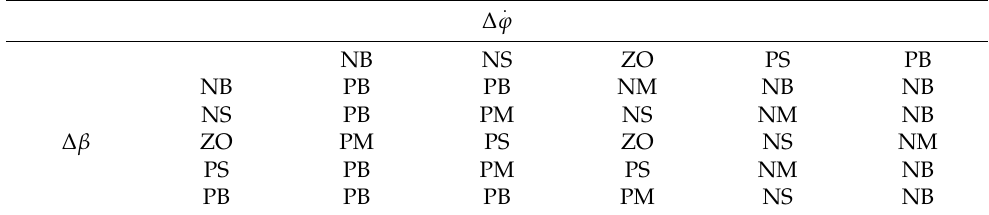
Table 1. Fuzzy Table 1. Fuzzy rules.